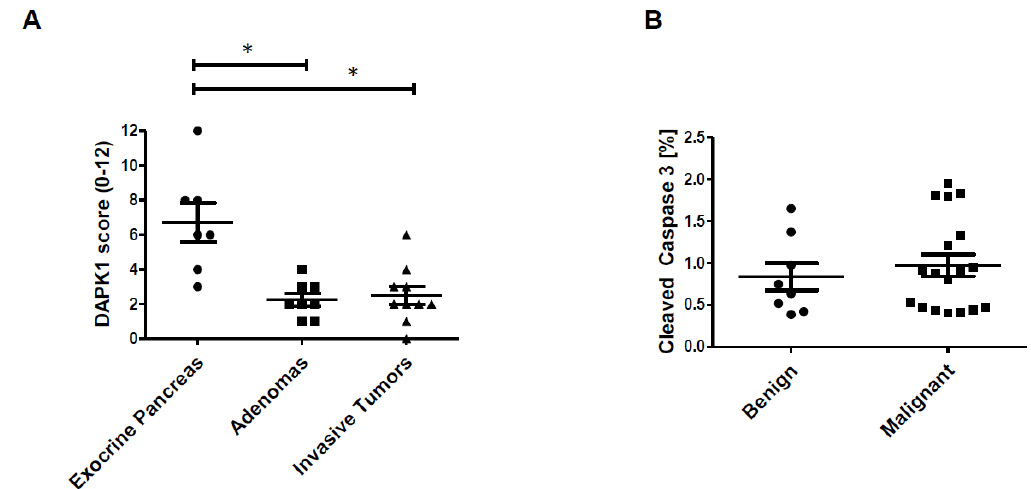
Figure 5. DAPK1 and caspase 3 IRS in different stages of tumorigenesis in the RIP1Tag2 mouse model. ( A ) Exocrine pancreas (N = 7, mean: 6.7 ± 1.1 SEM), adenomas (N = 8, mean: 2.3 ± 0.37 SEM) and invasive tumours (N = 10, mean: 2.5 ± 0.52 SEM). * P < 0.05. ( B ) Cleaved caspase 3 in benign (hyperplastic adenomas/angiogenic tumours, N = 8, mean: 0.84 ± 0.16) versus malignant (invasive tumours, N = 18, mean: 0.97 ± 0.13 SEM) tumours presented as positive cells in %.